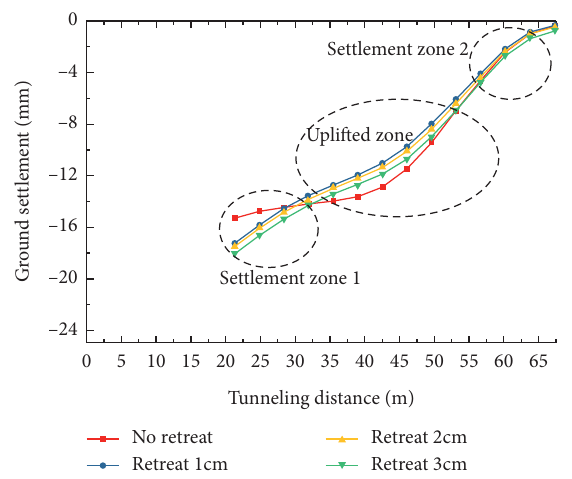
Figure 21: The longitudinal ground surface settlement is caused by pipe section